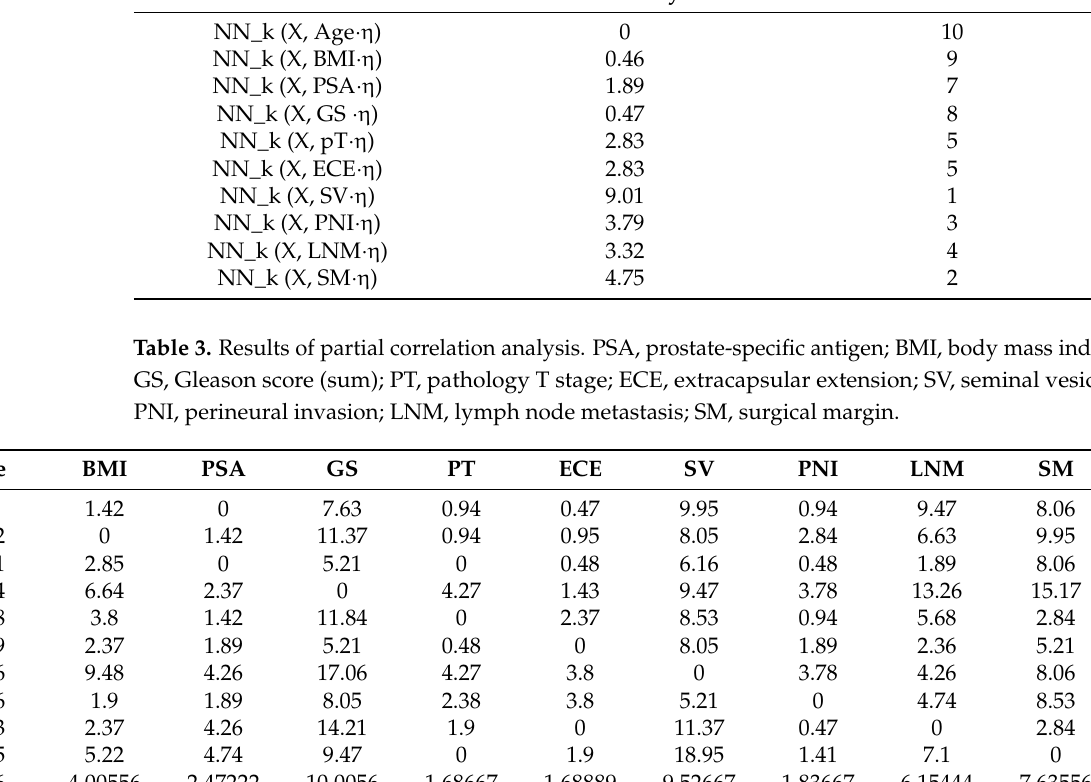
Table 2. Results of feature sensitivity analysis.